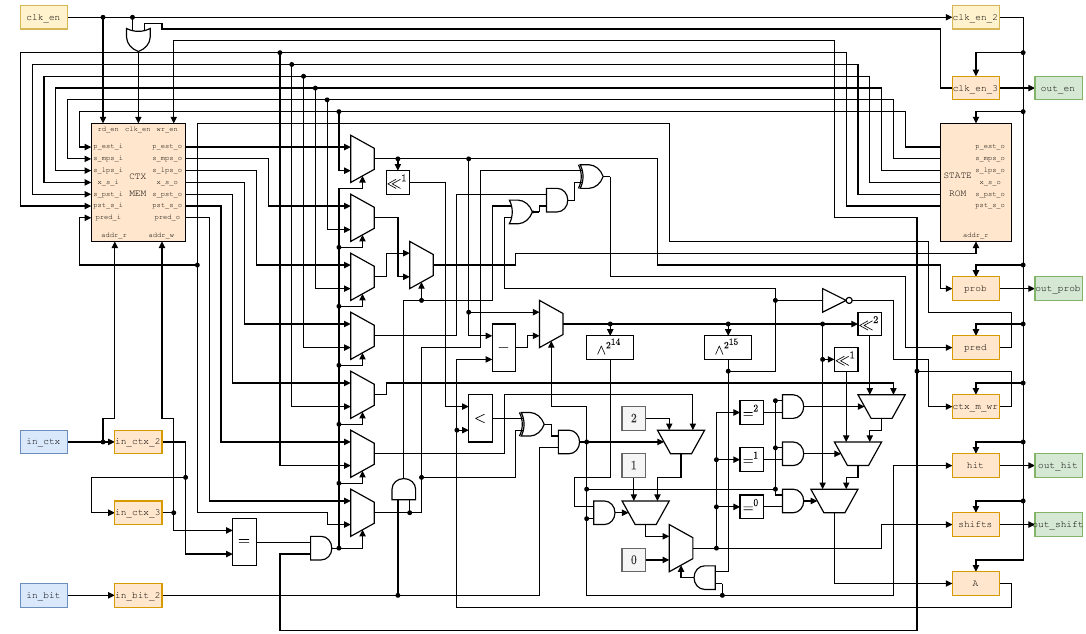
Figure 10. MQ-coder first and second stages. The context and bit from the BPC are input, and a probability, shift, and hit (correct prediction or not) are